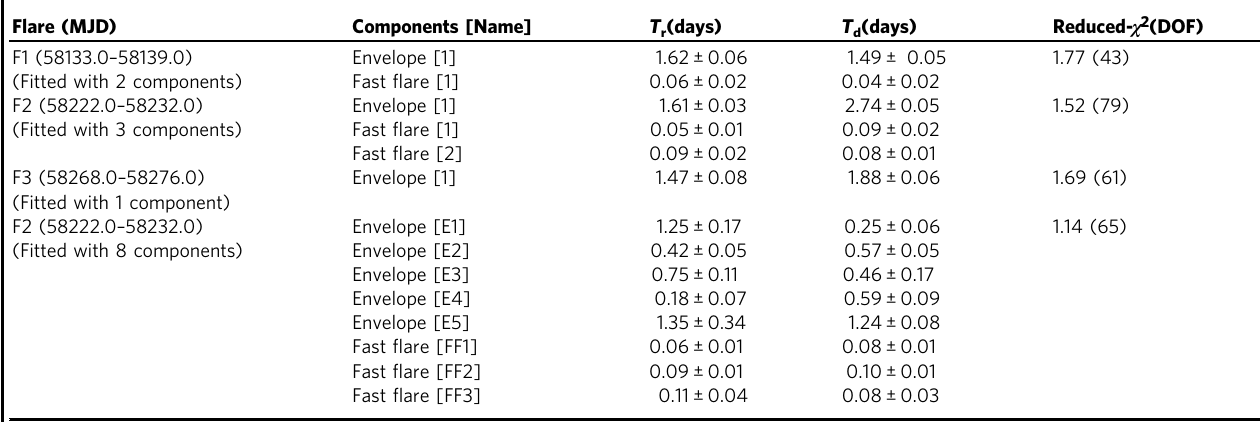
Table 1 Temporal characteristics of Flares.